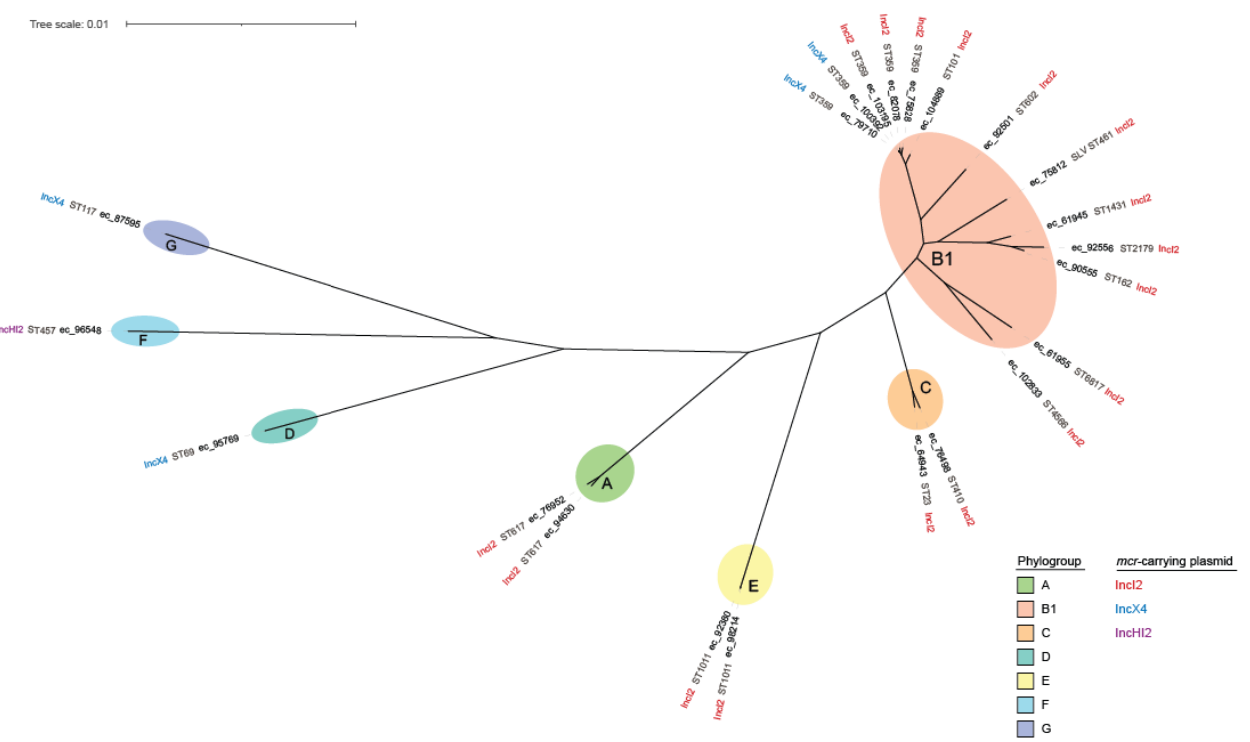
Figure 2. Core-genome SNP tree of 22 mcr-positive E. coli isolates. Sequence types (STs) and mcr- plasmid types are indicated next to the isolate names. Different E. coli phylogroups are shown by colored ellipses.